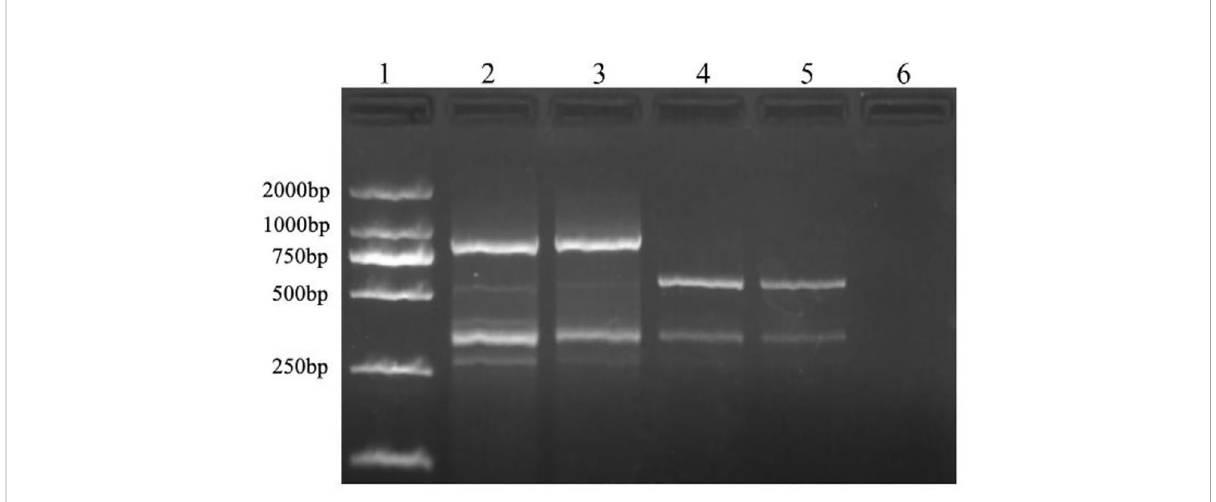
FIGURE 1 Speci fi c fragment of T. caries obtained with an inter simple sequence repeat primer (ISSR827). Lane 1: DL2000 DNA ladder; lane 2: T. controversa ; lane 3: T. laevis ; lanes 4-5: T. caries ; and lane 6: ddH 2